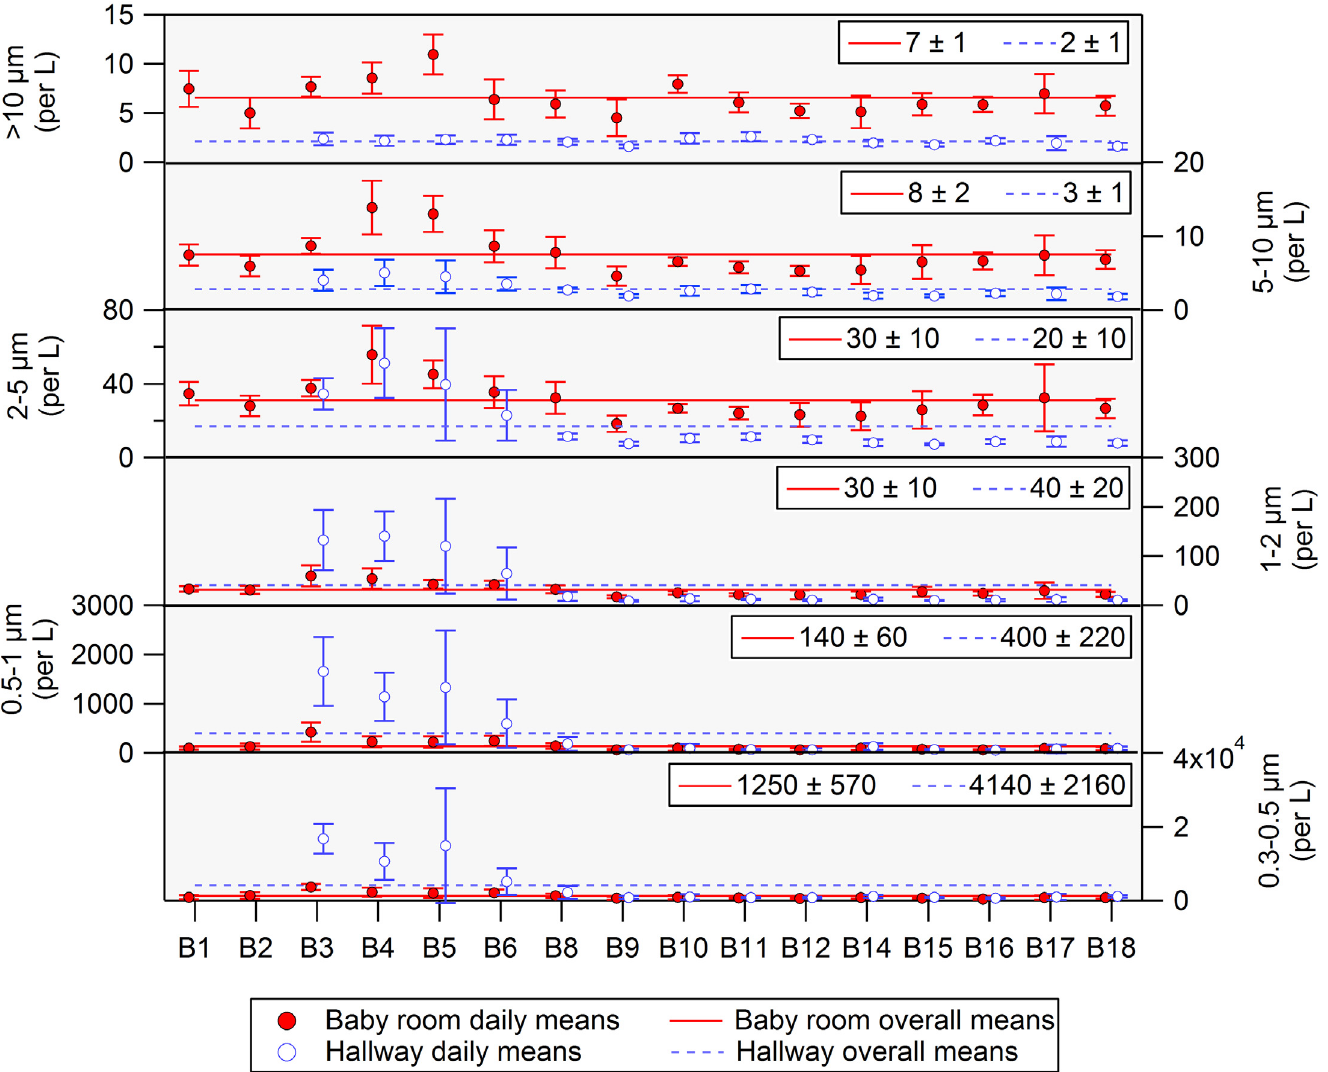
Fig 2. Size-resolved particle number concentrations measured in baby rooms and in the hallway. Data are averages of 1-day mean concentrations ( ± standard deviation). Boxed values in each frame indicate overall means obtained during the 1-year monitoring campaign. Note that due to sampling at 0.8 m height, reported number concentration for particles > 10 μ m may be overestimated compared to room-average values